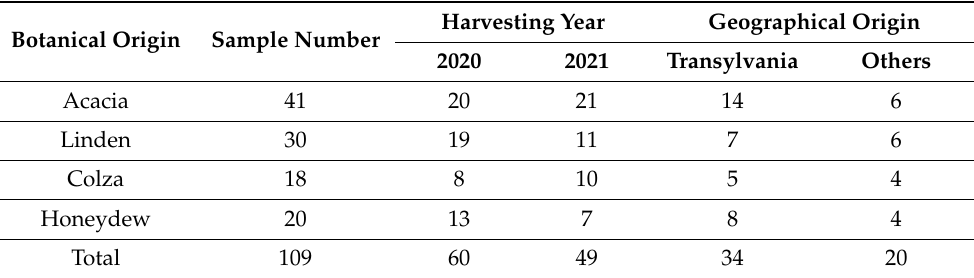
Table 1. The honey botanical origin, year of harvest and geographical distribution of the authentic honey